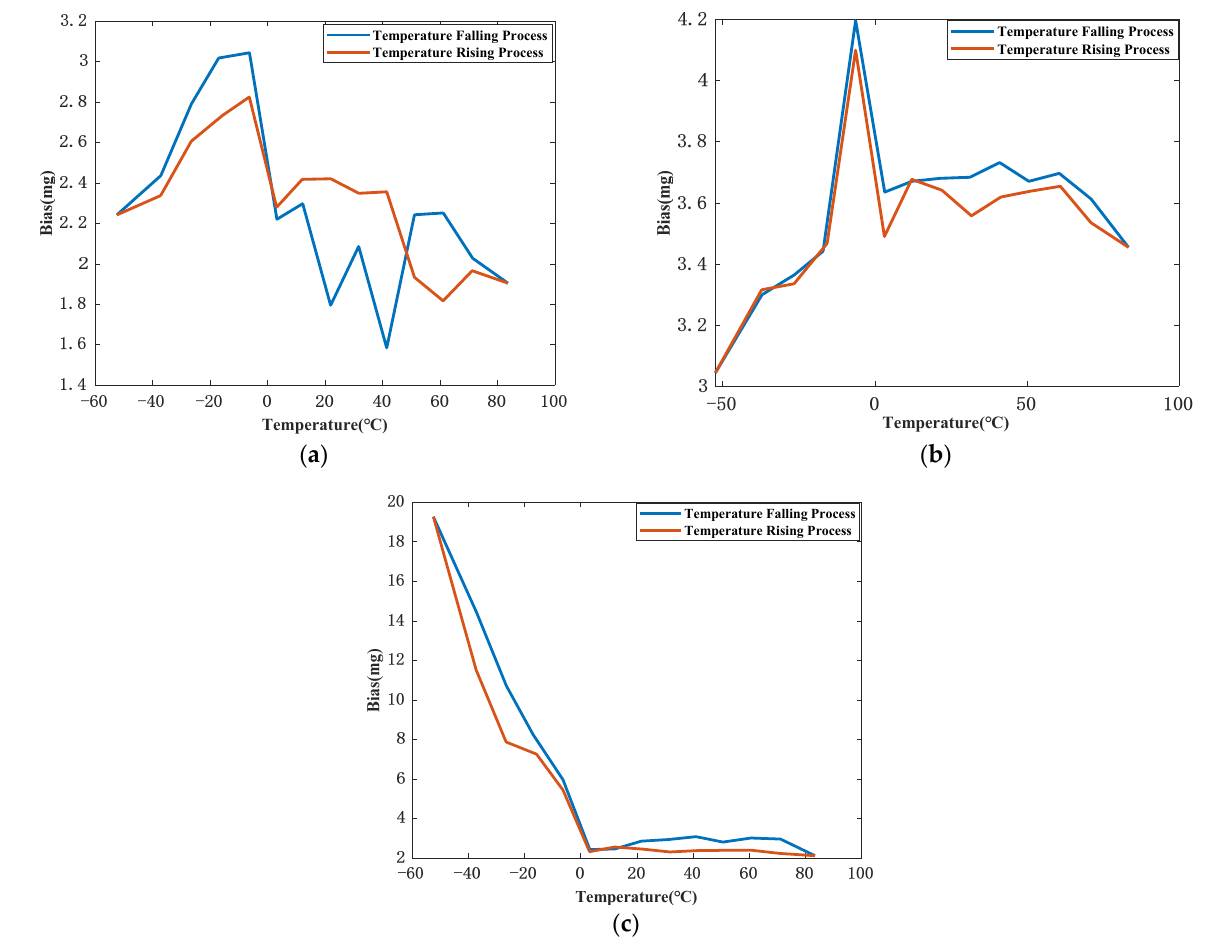
Figure 7. ( a ) is the bias of JB-KT8 #1 at different temperature; ( b ) is the bias of JB-KT8 #2 at different temperature; ( c ) is the bias of JB-KT8 #3 at different temperature.